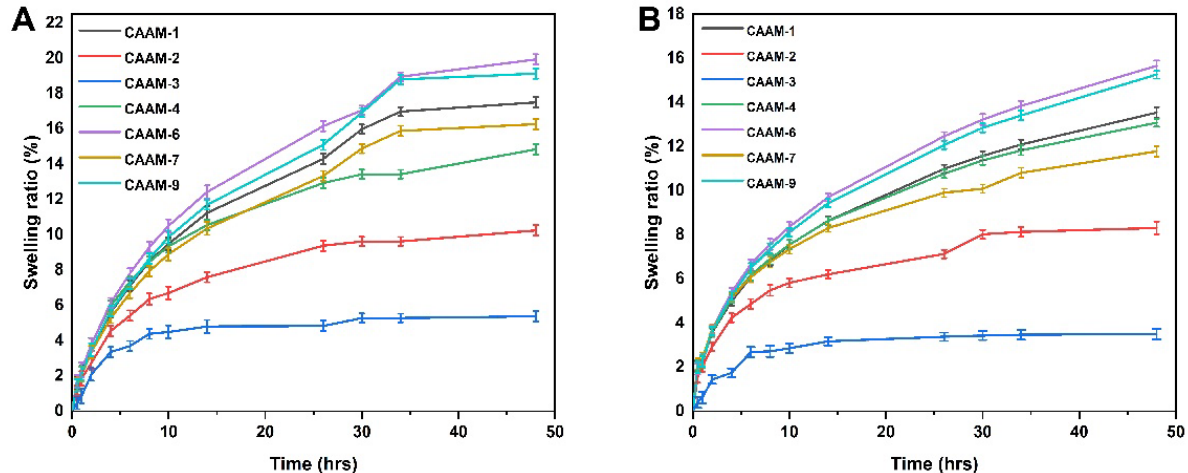
Figure 5. Swelling curves of hydrogels over time at pH 1.2 ( A ) and pH 7.4 ( B ).